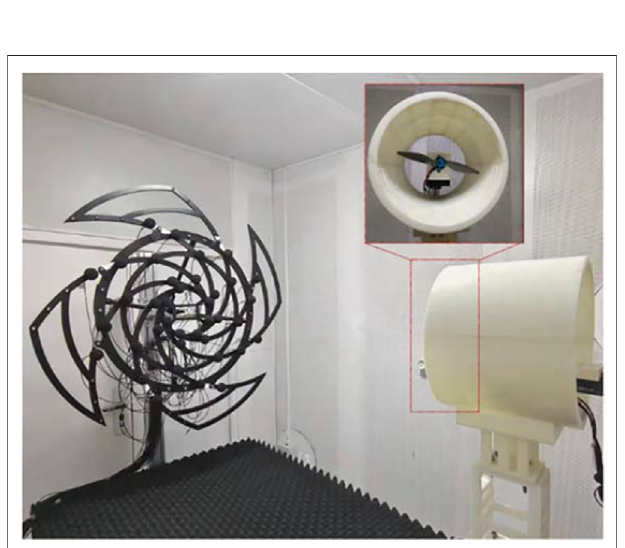
FIGURE 7 | Test system arranged in the anechoic chamber.